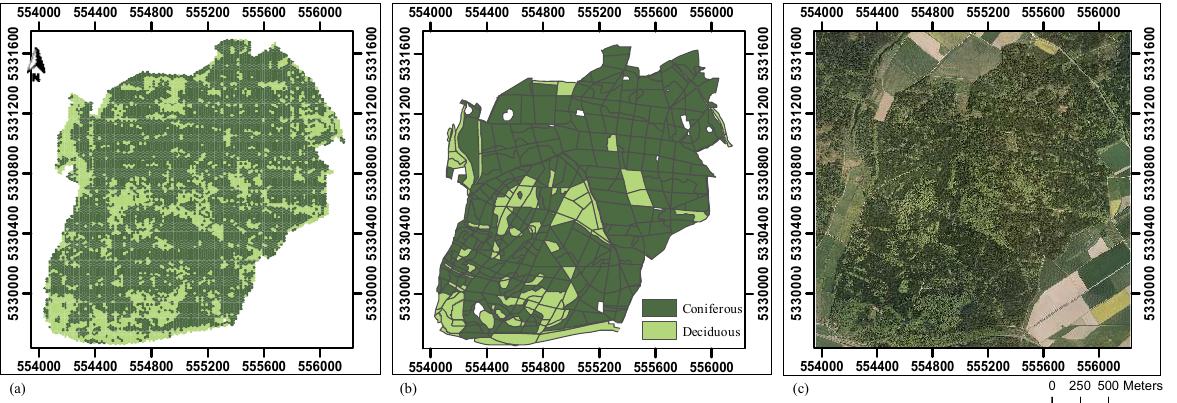
Figure 5. Application of the classification model in Biberach. ( a ) Map of deciduous- and coniferous-dominated forest based on combined leaf-on and leaf-off TerraSAR-X images (acquired in 2008 and 2009) preprocessed with the ALS DTM; ( b ) official forest stand map (established 2007); ( c ) ortho-photographs (acquired on